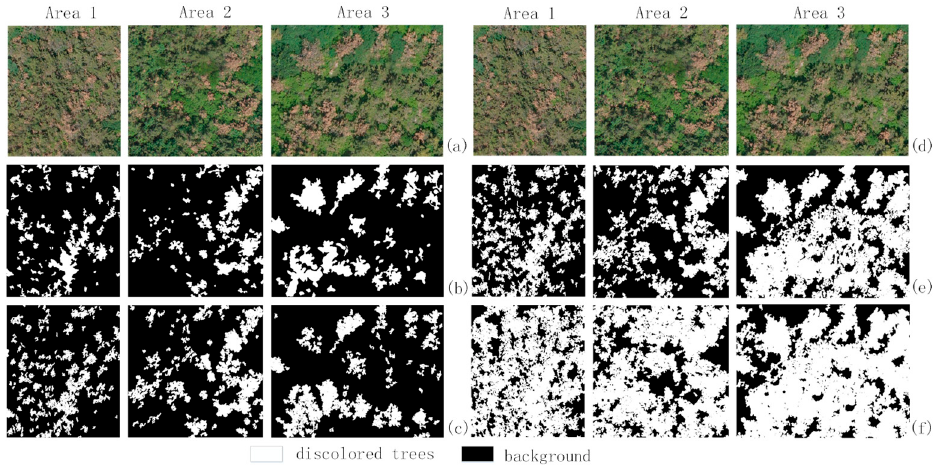
Figure 6. Comparison results of three vegetation indices. ( a ) UAV image; ( b ) ground truth; ( c ) m(ExG-ExR); ( d ) UAV image; ( e ) ExG; and ( f ) ExG-ExR. Table 1. The average accuracy of different results extracted by three indices from the three regions.